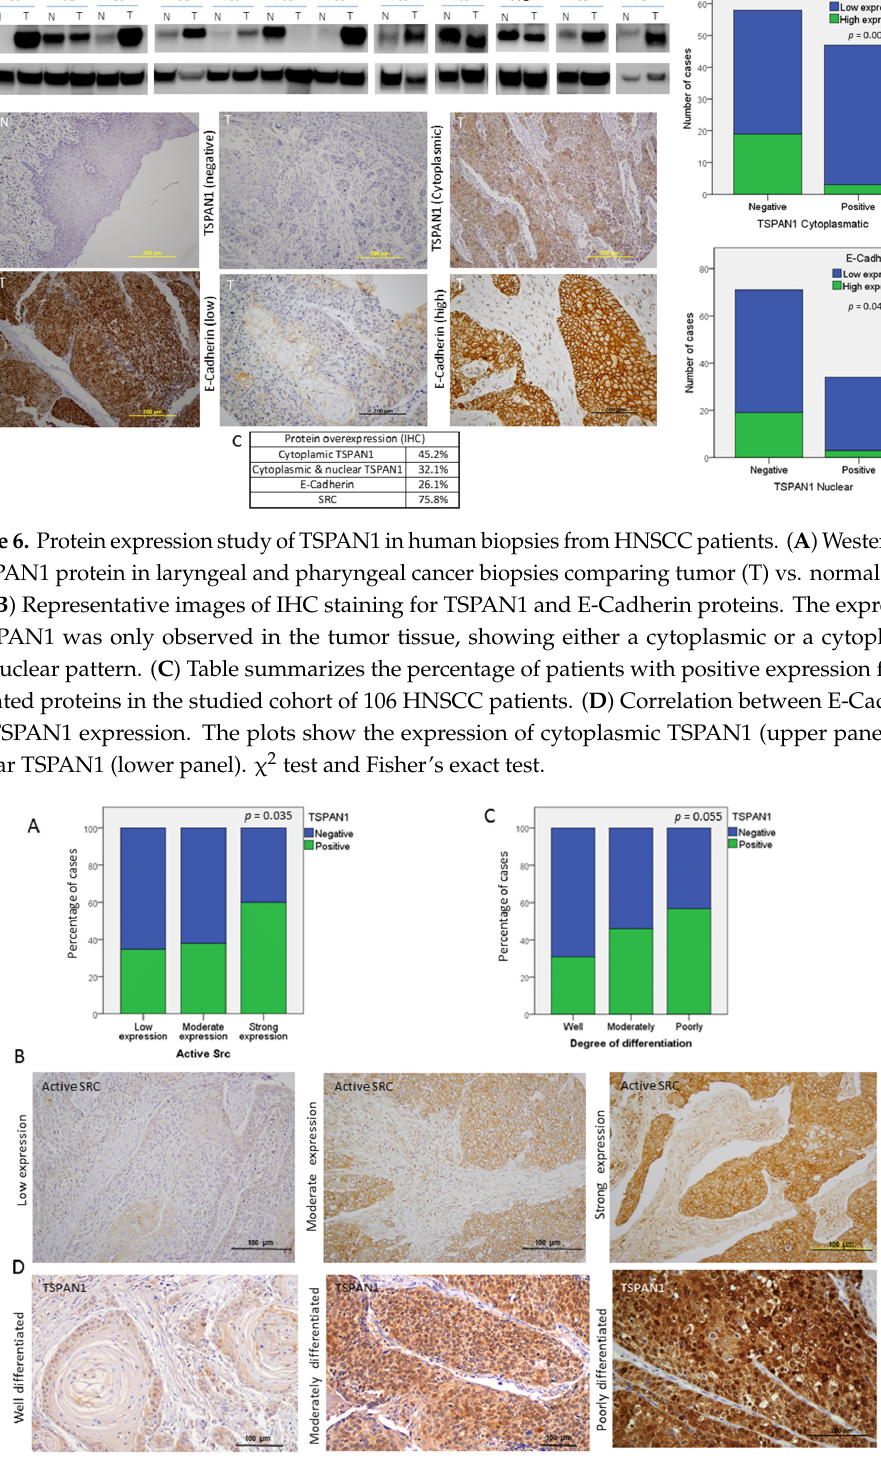
Figure 7. Associations of TSPAN1 expression with active SRC and with the degree of tumor differentiation. 1 1 ( A ) Direct correlation of TSPAN1 expression with active SRC. χ 2 test and Fisher’s exact test, * ( p < 0.05). ( B ) Representative IHC images for the di ff erent expression levels of active SRC (low, moderate and high). ( C ) TSPAN1 expression tends to correlate with the degree of tumor di ff erentiation, showing higher TSPAN1 expression in patients with poorly di ff erentiated tumors. ( D ) Representative IHC images to illustrate TSPAN1 expression along di ff erent degrees of tumor di ff erentiation (well, moderately and poorly) as